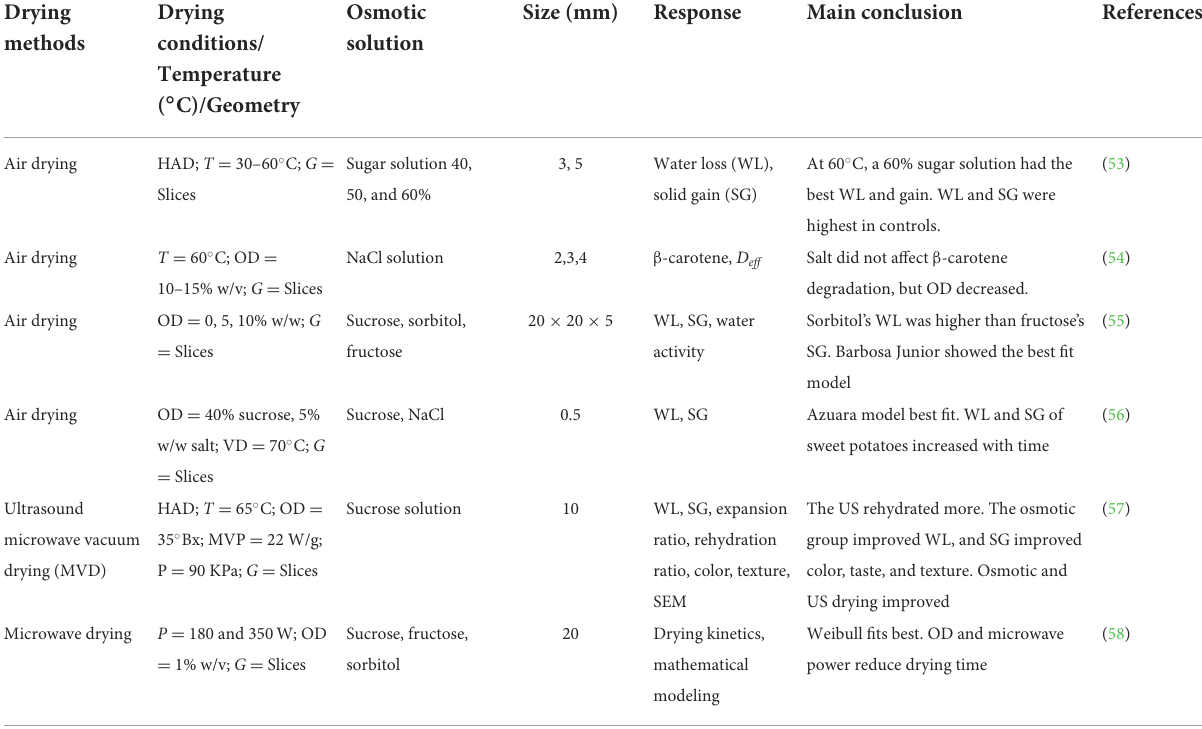
TABLE 4 Application of different osmotic solutions as pretreatments along with varying methods of drying for optimizing drying protocols for sweet